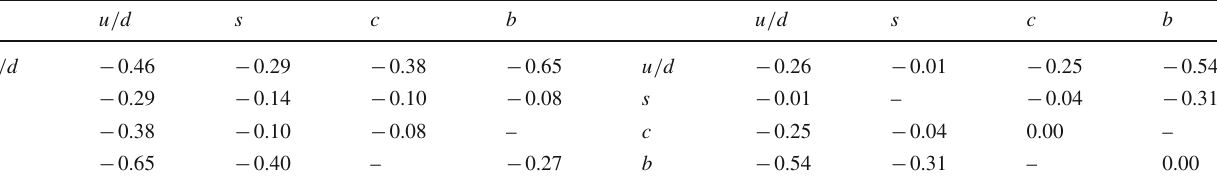
Table 20 The intercepts of the various meson trajectories, arranged by quark content. On the left are the vector meson trajectories, on the right the pseudoscalar